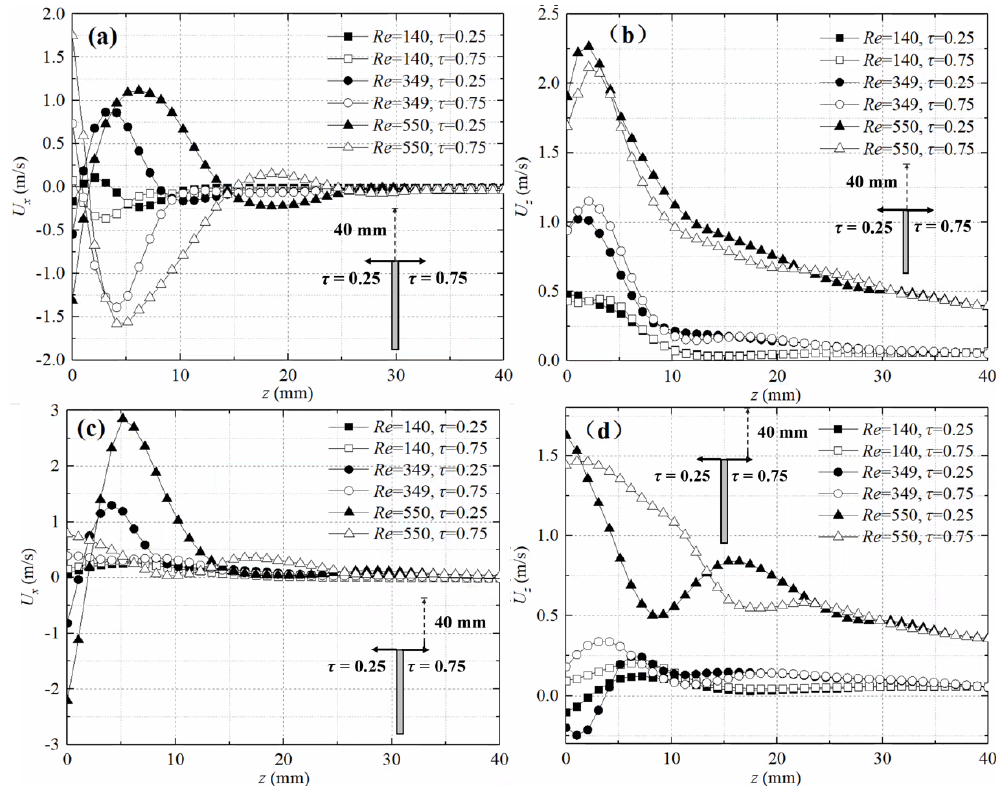
Figure 8. Time averaged velocity profiles extracted at different streamwise lines: ( a ) U x profile along the midspan line ( x = 0, 0 < z < 40 mm), ( b ) U z profile along the midspan line ( x = 0, 0 < z < 40 mm), ( c ) U x profile along the line distancing 15 mm away from the midspan line ( x = 15, 0 < z < 40 mm) and ( d ) U z profile along the line distancing 15 mm away from the midspan line ( x = 15, 0 < z < 40